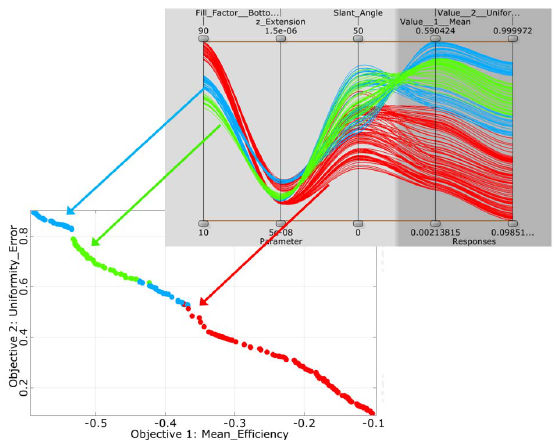
Fig. 2. Anthill plot with Pareto front designs (lower left plot) representing the trade-off between Uniformity Error and Mean Efficiency of a slanted grating. The colours correspond to the colour of the cluster analysis illustrated in the parallel coordinates plot (upper right plot). Here, the Fill Factor was separated into 3 clusters.